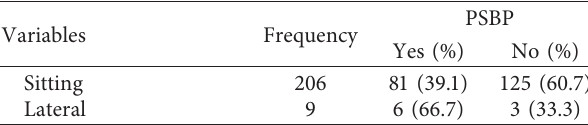
Table 2: Associated factors with PSBP of the study participants at the University of Gondar Comprehensive and Specialized